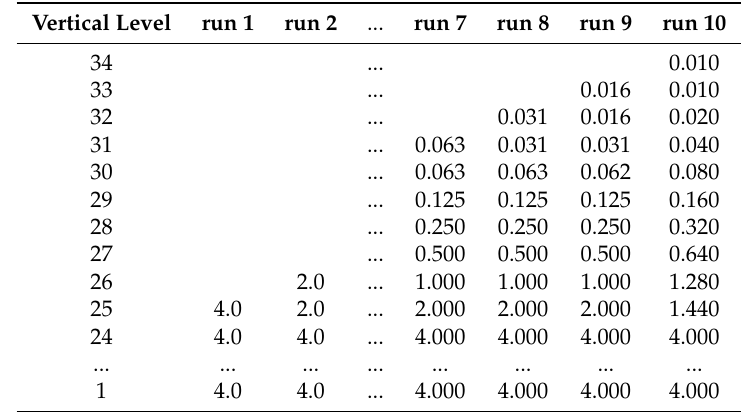
Table 2. Vertical discretization for the ten convergence test runs. The thickness of each level is given in percent σ . In run 1, all 25 levels have 4% σ . In run 2, the first 24 levels have a thickness of 4% σ , the last two, level 25 and 26 2% σ thick. Similar for the remaining runs. All values are rounded to three decimal places for